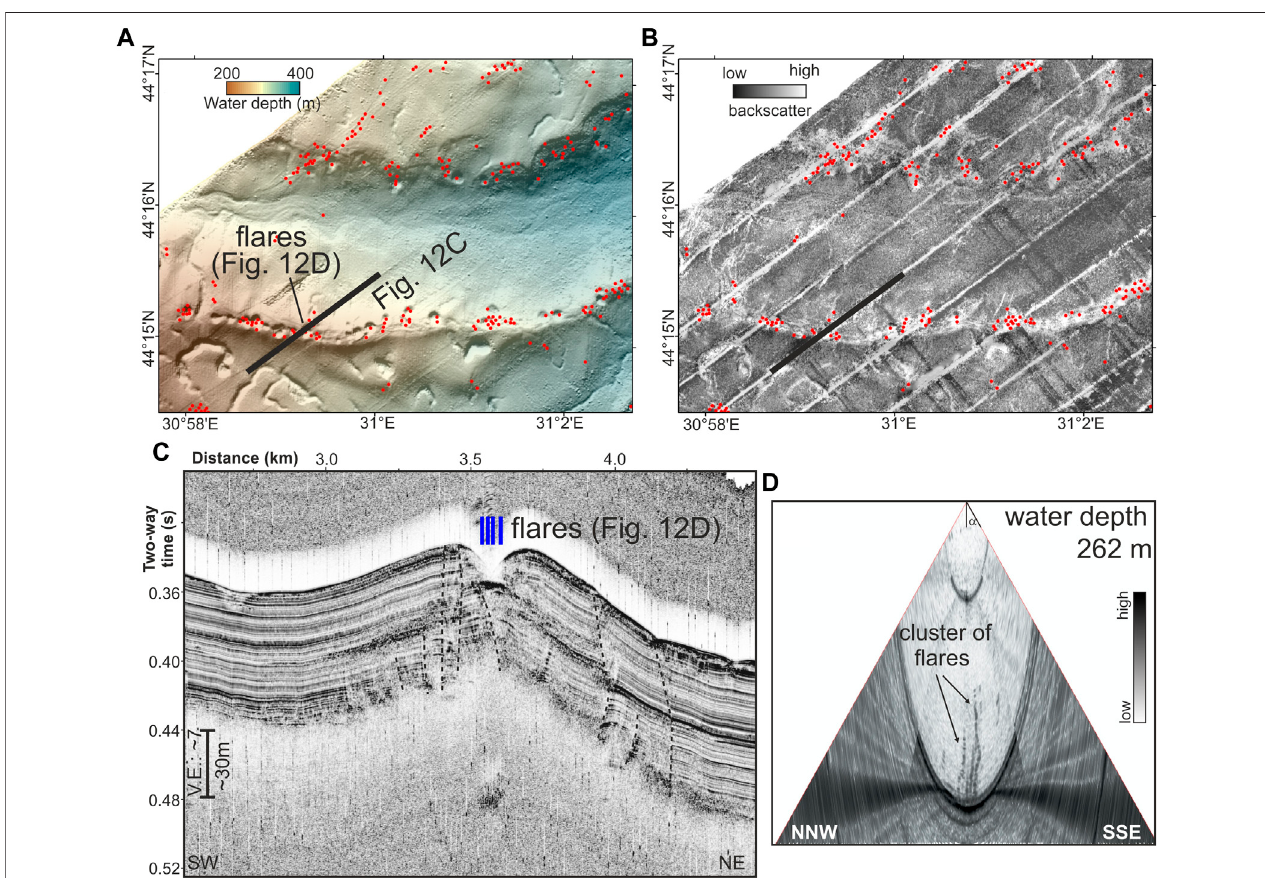
FIGURE12| Examplesofpockmark-chainsalongridgesandcanyonwallattheupper-slopeportionoftheN4channel: (A) multibeambathymetryand (B) sea fl oor backscatter. Structural focusing of gas migration toward the highest elevation creates gas outlets on top of the ridges. Additional gas venting comes from faulting associatedwithsea fl oor instabilities and slumpingat thecanyon walls. Thesub-bottompro fi lerdata (C) show smalloffset faults(blackdashed lines)aroundapockmark andthatsedimentsareremovedfromthecentralportionofthe(circular)depression. (D) InsidethepockmarkseveralgasventsareseenintheEM710watercolumn data. Beam-opening angle α is 60 °